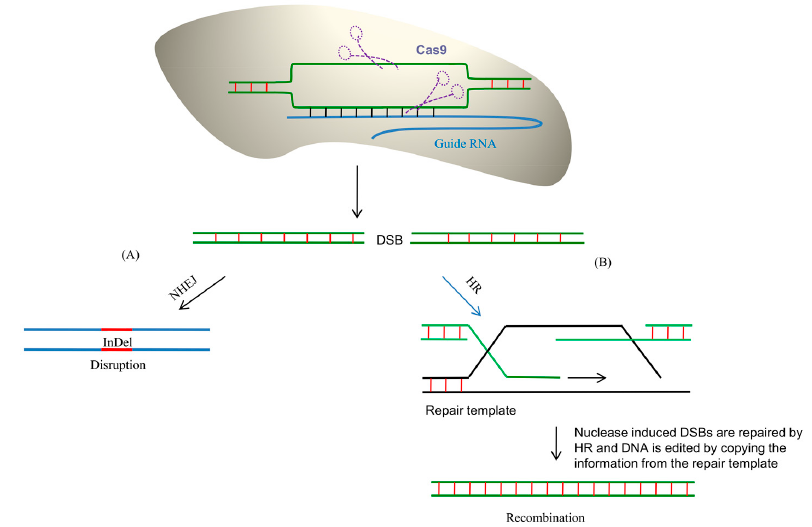
Figure 5. Genome editing mechanism. A double stranded break is generated by a nuclease, such as Cas9 in the genome and DSB produced can be repaired in two ways. ( A ) Non-homologous end joining can also repair the DSBs by making small insertions and deletions. ( B ) HR driven repair mechanism can correct the DSBs from the template donor plasmid which has modifications to be introduced in the